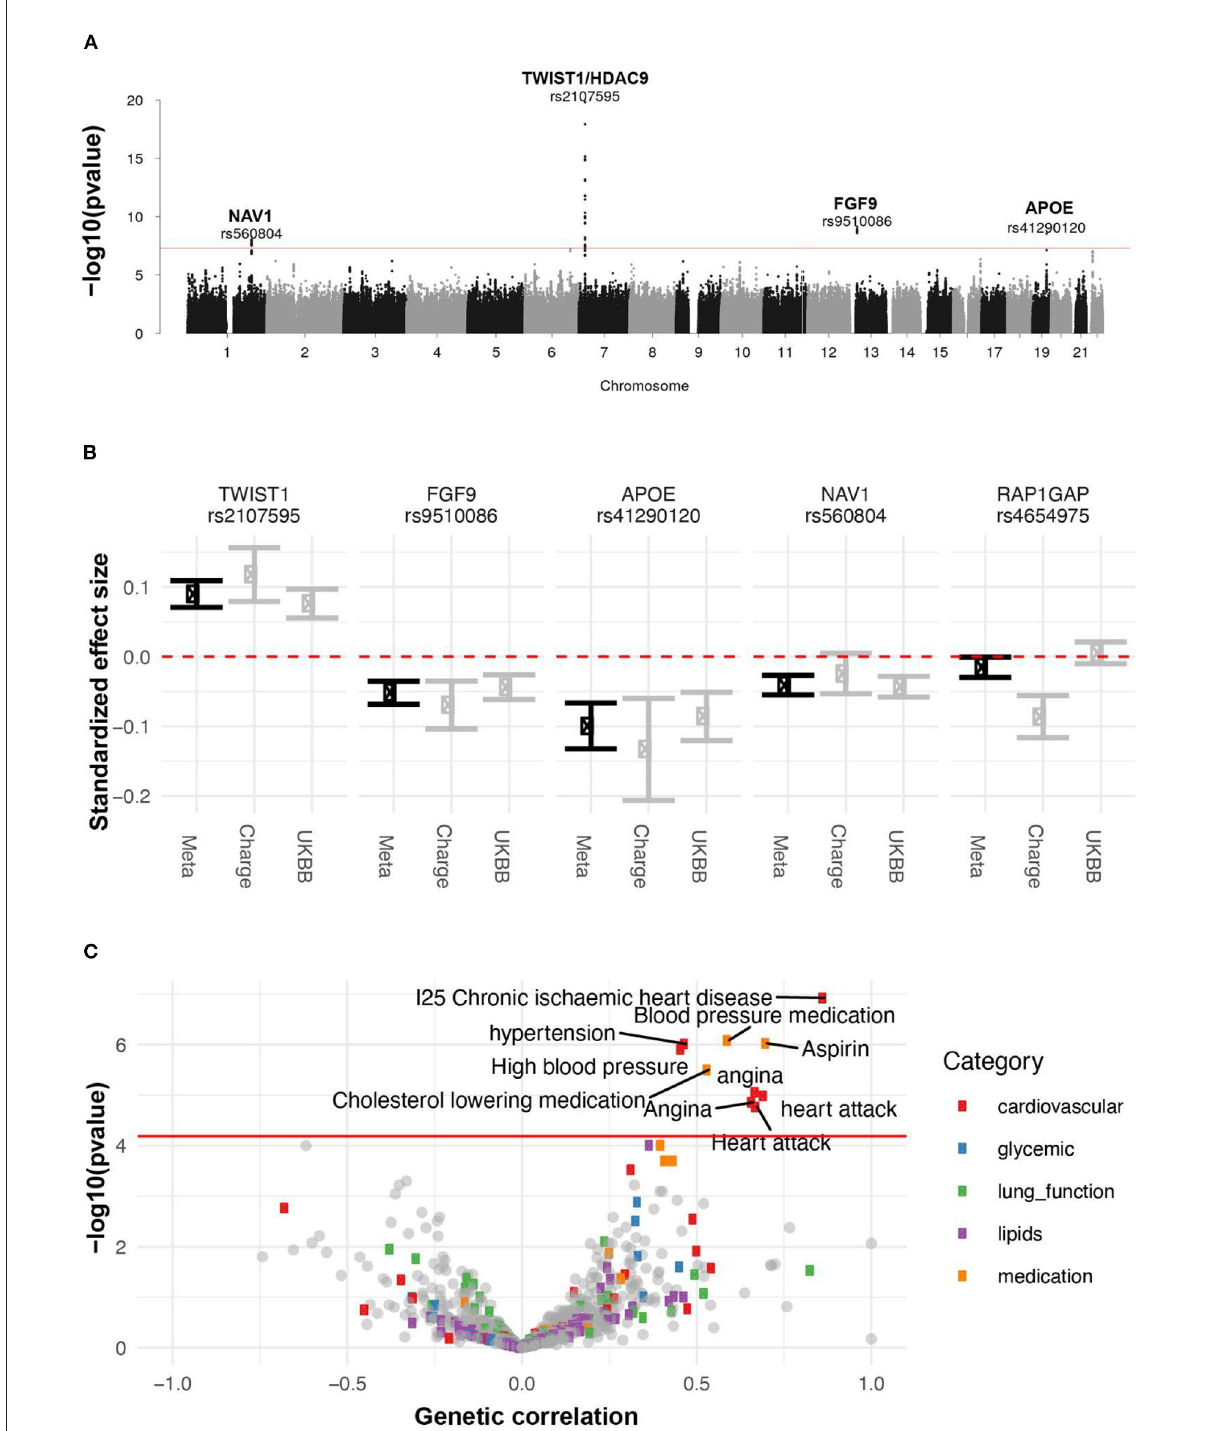
FIGURE10 Genetic analysis of AAC. (A) GWAS Manhattan plot. Association of each SNP -log(p-values) ordered by chromosome. Genome-wide significance cut-off (p-value 5 x 10 − 8 ) is shown as a red line. (B) Approximate standardized effect size estimates for the UK Biobank data, CHARGE consortium data, and the meta-analysis at the four genome-wide significant loci in this study, and one additional locus previously reported by CHARGE. (C) Genetic correlation and p-value for correlation between AAC and other complex traits. X-axis: Estimated correlation. Y-axis: -log10(p-value). The horizontal line is at the Bonferroni-corrected p -value